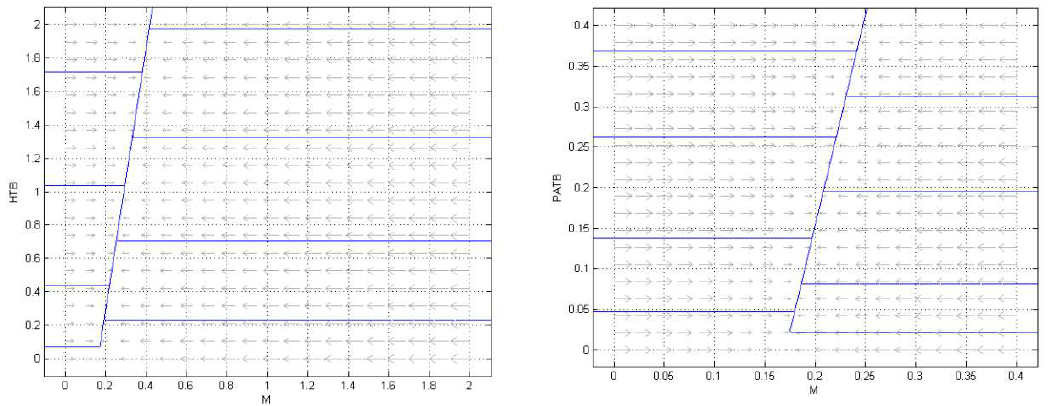
H and . Figure 7. Phase transition plot of M with H TB and P ATB . TB